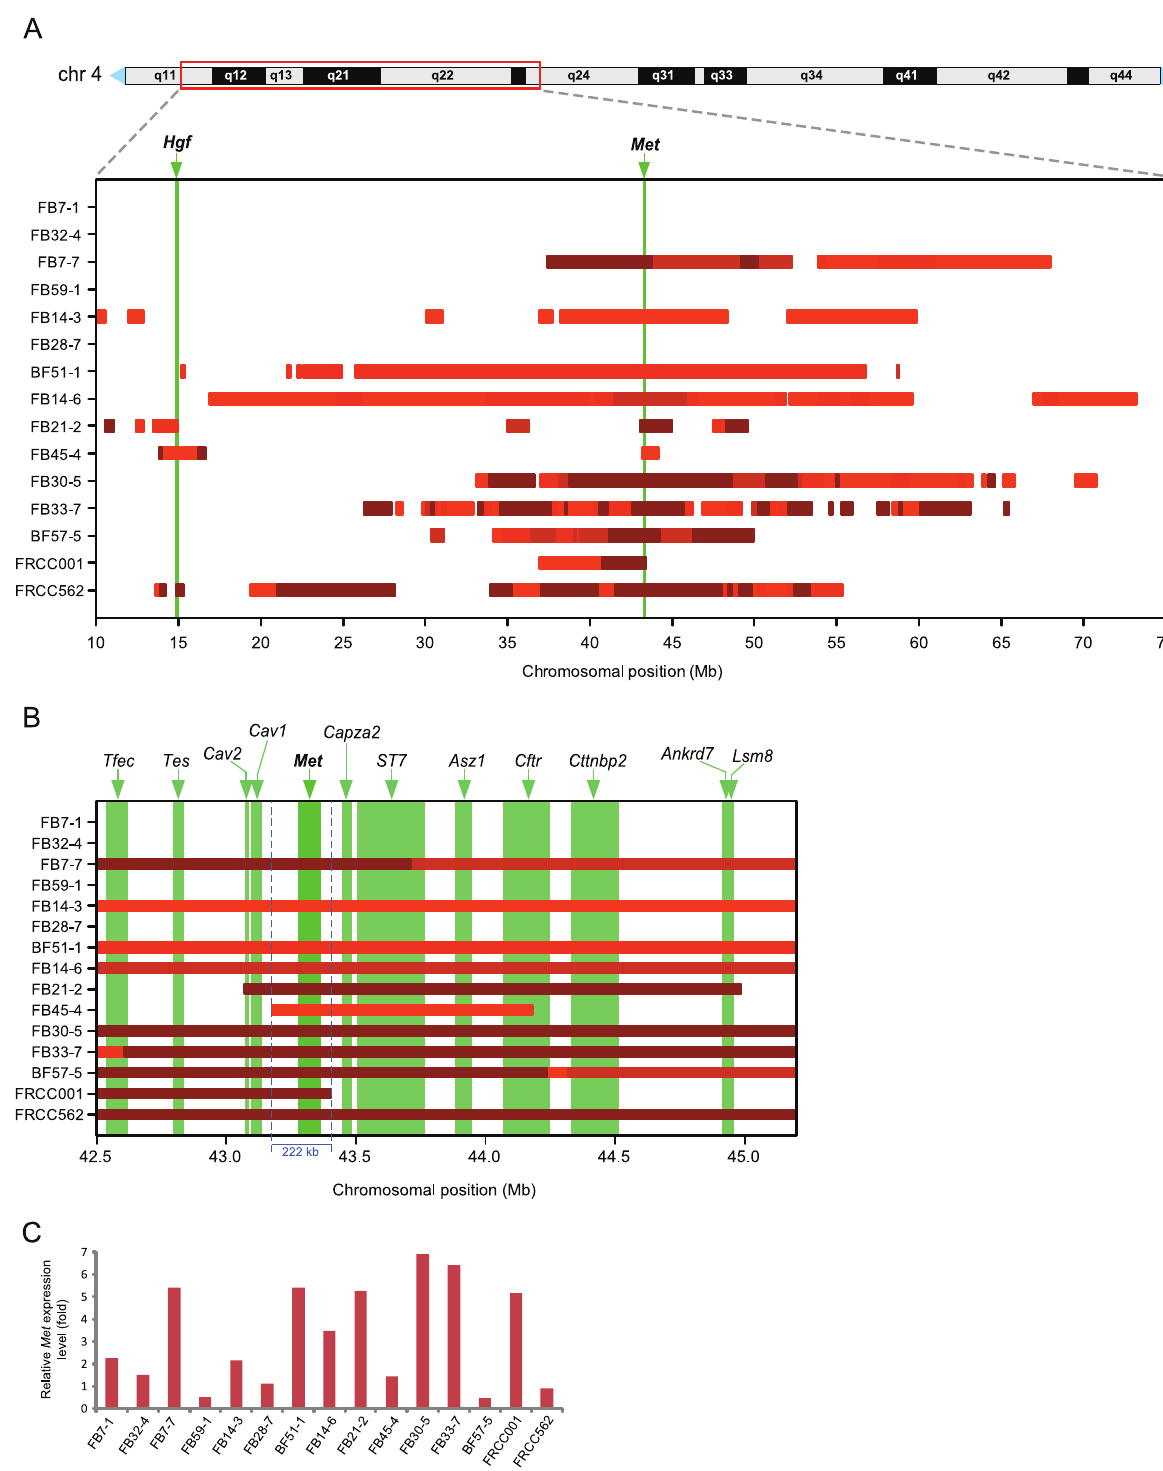
PLOS ONE | www.plosone.org 5 August 2012 | Volume 7 | Issue 8 |